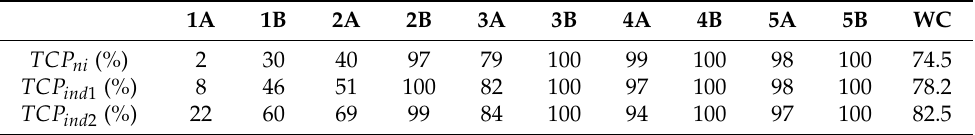
Table 4. Overall (whole cohort, WC) and group-specific tumor control probability when the injected activity is not adapted to each group ( TCP ni ), and when it is adapted according to Strategy 3 with according to absorbed dose in the tumor and radioresistance of tumor cells. Activities administered to each group are A 0 + 9 ∆ A /8 (Group 1A), A 0 + 7 ∆ A /8 (Group 1B), A 0 + 5 ∆ A /8 (Group 2A), A 0 + 3 ∆ A /8 (Group 2B), A 0 + ∆ A /8 (Group 3A), A 0 − ∆ A /8 (Group 3B), A 0 − 3 ∆ A /8 (Group 4A), A 0 − 5 ∆ A /8 (Group 4B), A 0 − 7 ∆ A /8 (Group 5A), A 0 − 9 ∆ A /8 (Group 5B).